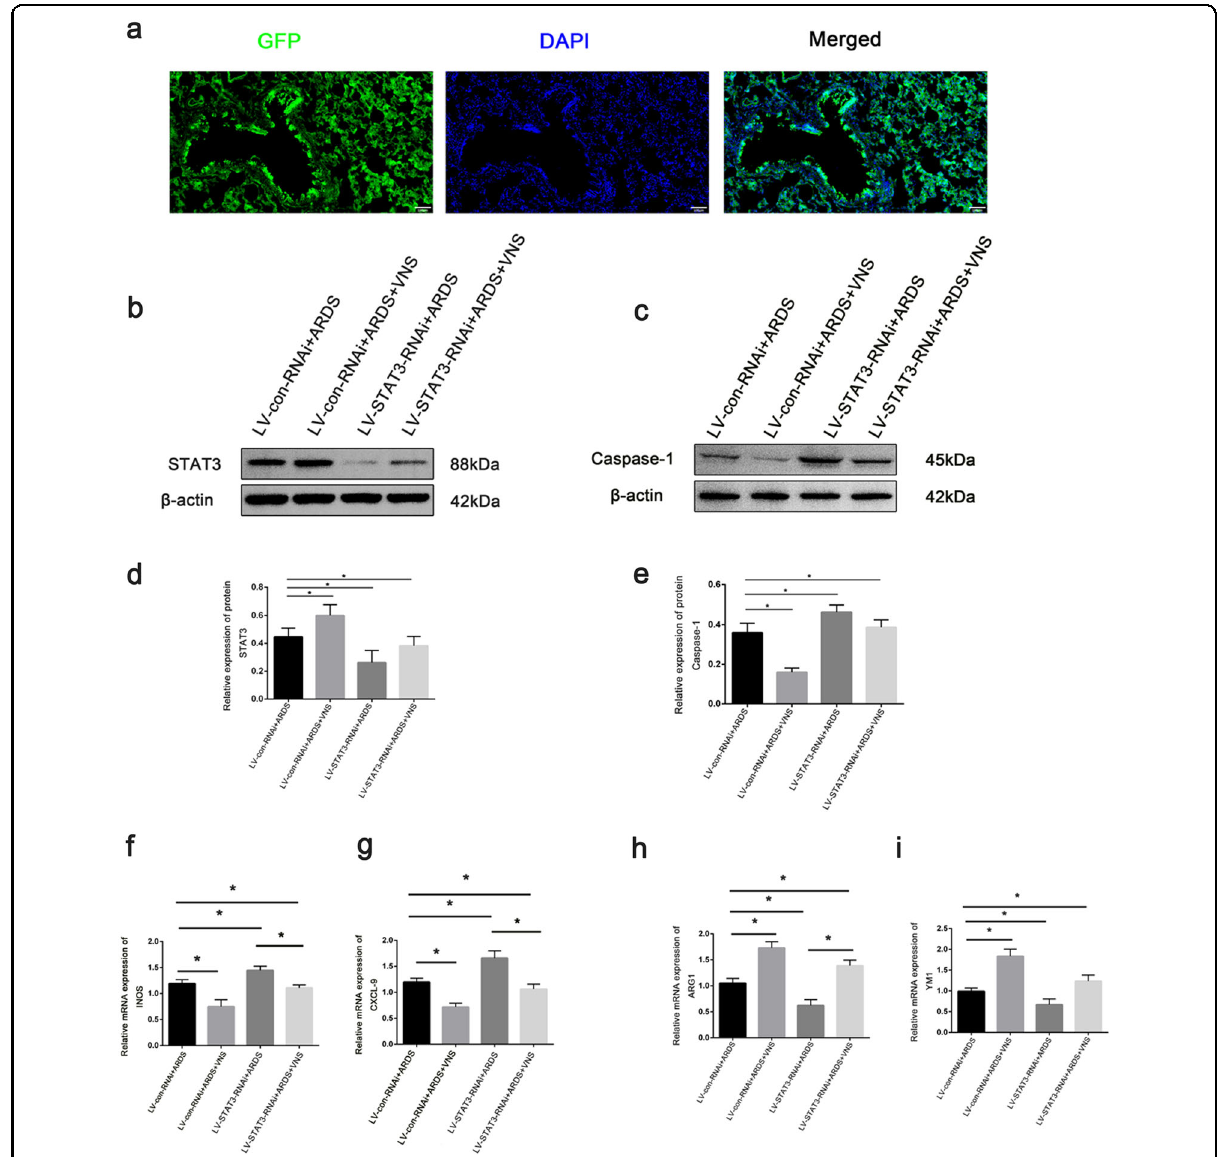
Fig. 5 Knockdown of STAT3 attenuates VNS ’ s effects on STAT3, Caspase-1, and M1M2 macrophage phenotypes. a Fluorescence images of GFP (green) in injected lung 7 days after lentiviruses were stereotaxically injected (scale bar = 100 μ m). b Representative western blotting images of STAT3 expression in the LV-con-RNAi + ARDS group, LV-con-RNAi + ARDS + VNS group, LV-STAT3-RNAi + ARDS group, and LV-STAT3-RNAi + ARDS + VNS group ( n = 6 biological replicates). c Representative western blotting analysis images of Caspase-1 expression in the LV-con-RNAi + ARDS group, LV- con-RNAi + ARDS + VNS group, LV- STAT3-RNAi + ARDS group, and LV-STAT3-RNAi + ARDS + VNS groups ( n = 6 biological replicates). d Comparison of mean intensity ratios for STAT3. e Comparison of mean intensity ratios for Caspase-1. f – i The mRNA levels of the M1 macrophage markers, iNOS and CXCL-9, and those of the M2 macrophage markers, Arg1 and Ym1, were measured in the LV-con-RNAi + ARDS group, LV-con-RNAi + ARDS + VNS group, LV-STAT3-RNAi + ARDS group, and LV-STAT3-RNAi + ARDS + VNS group by qPCR and normalized to GAPDH mRNA levels ( n = 6 biological replicates). The results are expressed as the mean ± SEM ( n = 6 biological replicates); * p < 0.05, ** p <